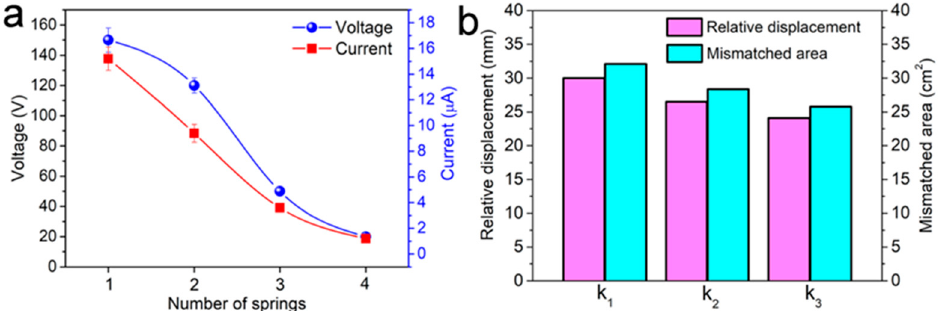
Figure 4. ( a ) Output voltage and current statistical results for the CS-TENGs with different numbers of springs fixed on each end. ( b ) Simulation results for the maximum relative displacement and the mismatched area between the inner cylinder and the outer tube for the CS-TENGs equipped with springs with increased stiffness coefficient.